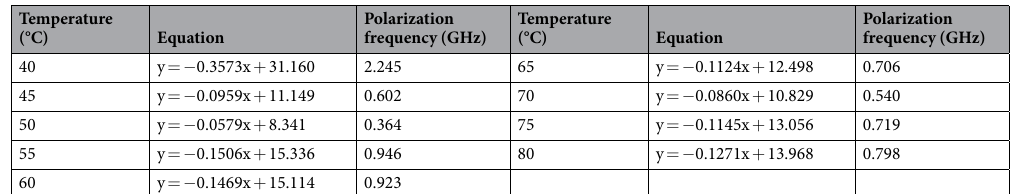
Table 3. The fitting equations of Cole-Cole curves and polarization frequencies for starch–water mixtures treated using conventional